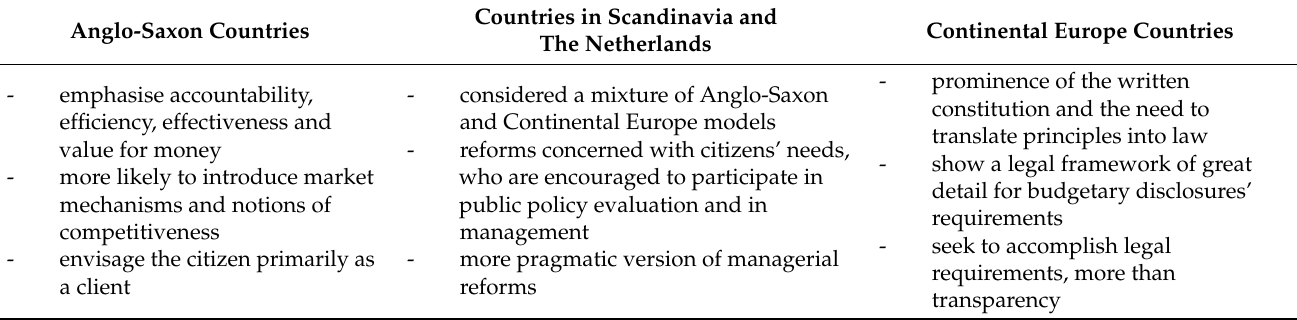
Table 2. Characteristics of Public Administration in Western-style